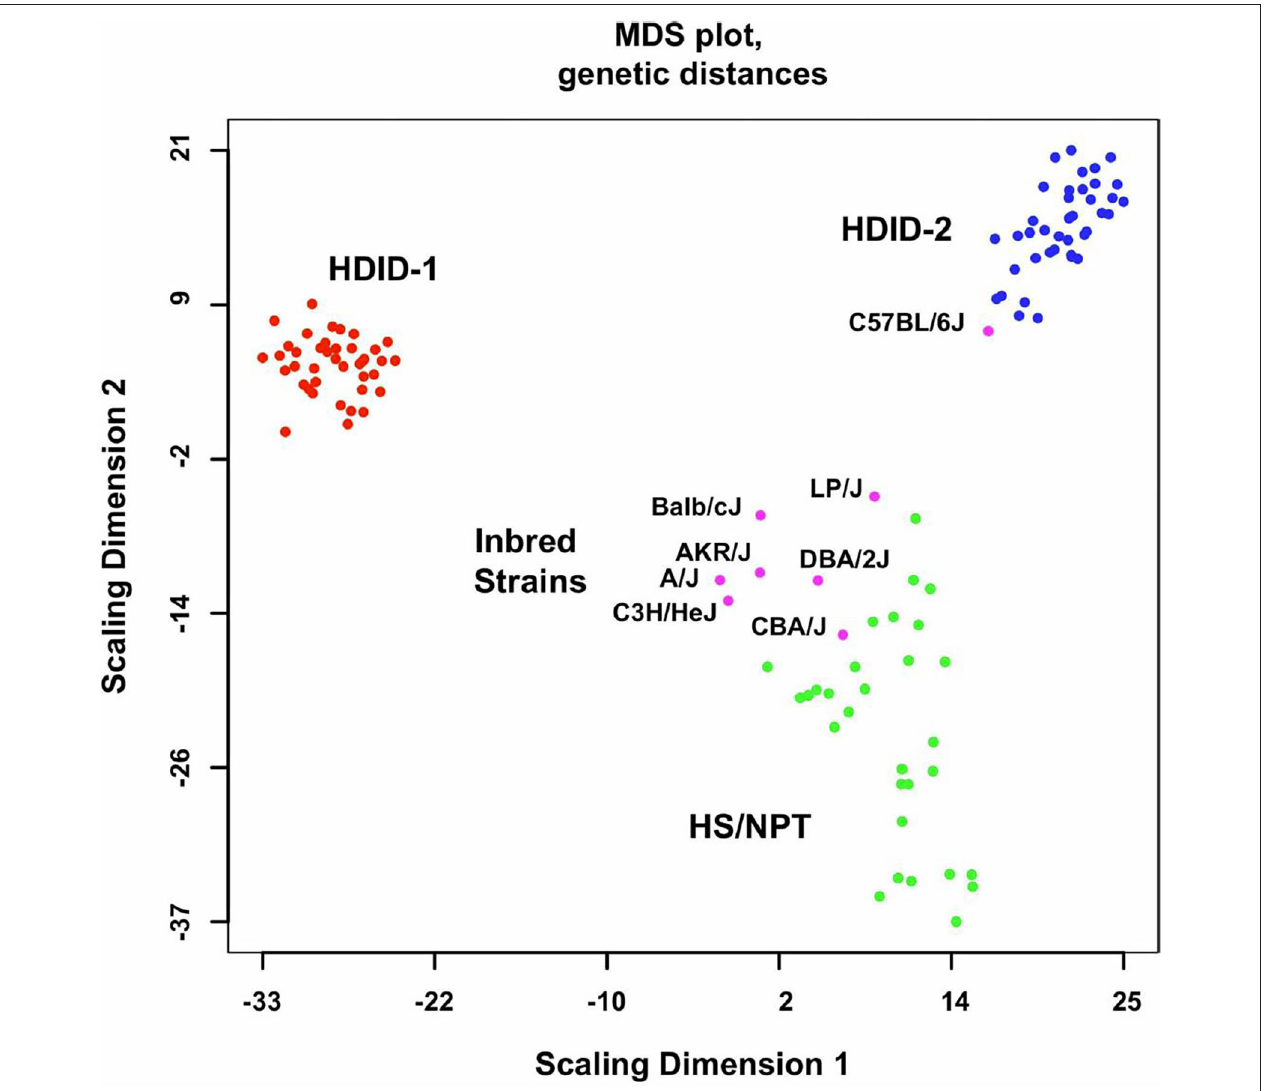
FIGURE 1 | Genome-wide genetic distances between the HDID-1 and -2 selected lines, HS/NPT animals and the inbred strains used to form the HS/NPT. Details of the animals used are found in the Methods in ( 52). Data are presented as a multidimensional scaling (MDS) plot. Note the greater dispersion in the HS/NPT animals when compared to the HDID-1 and HDID-2 selected lines and the differences between the two selected lines. Also note that among the inbred strains the C57BL/6J is distinct from the other 7 founders. Figure reprinted with permission from